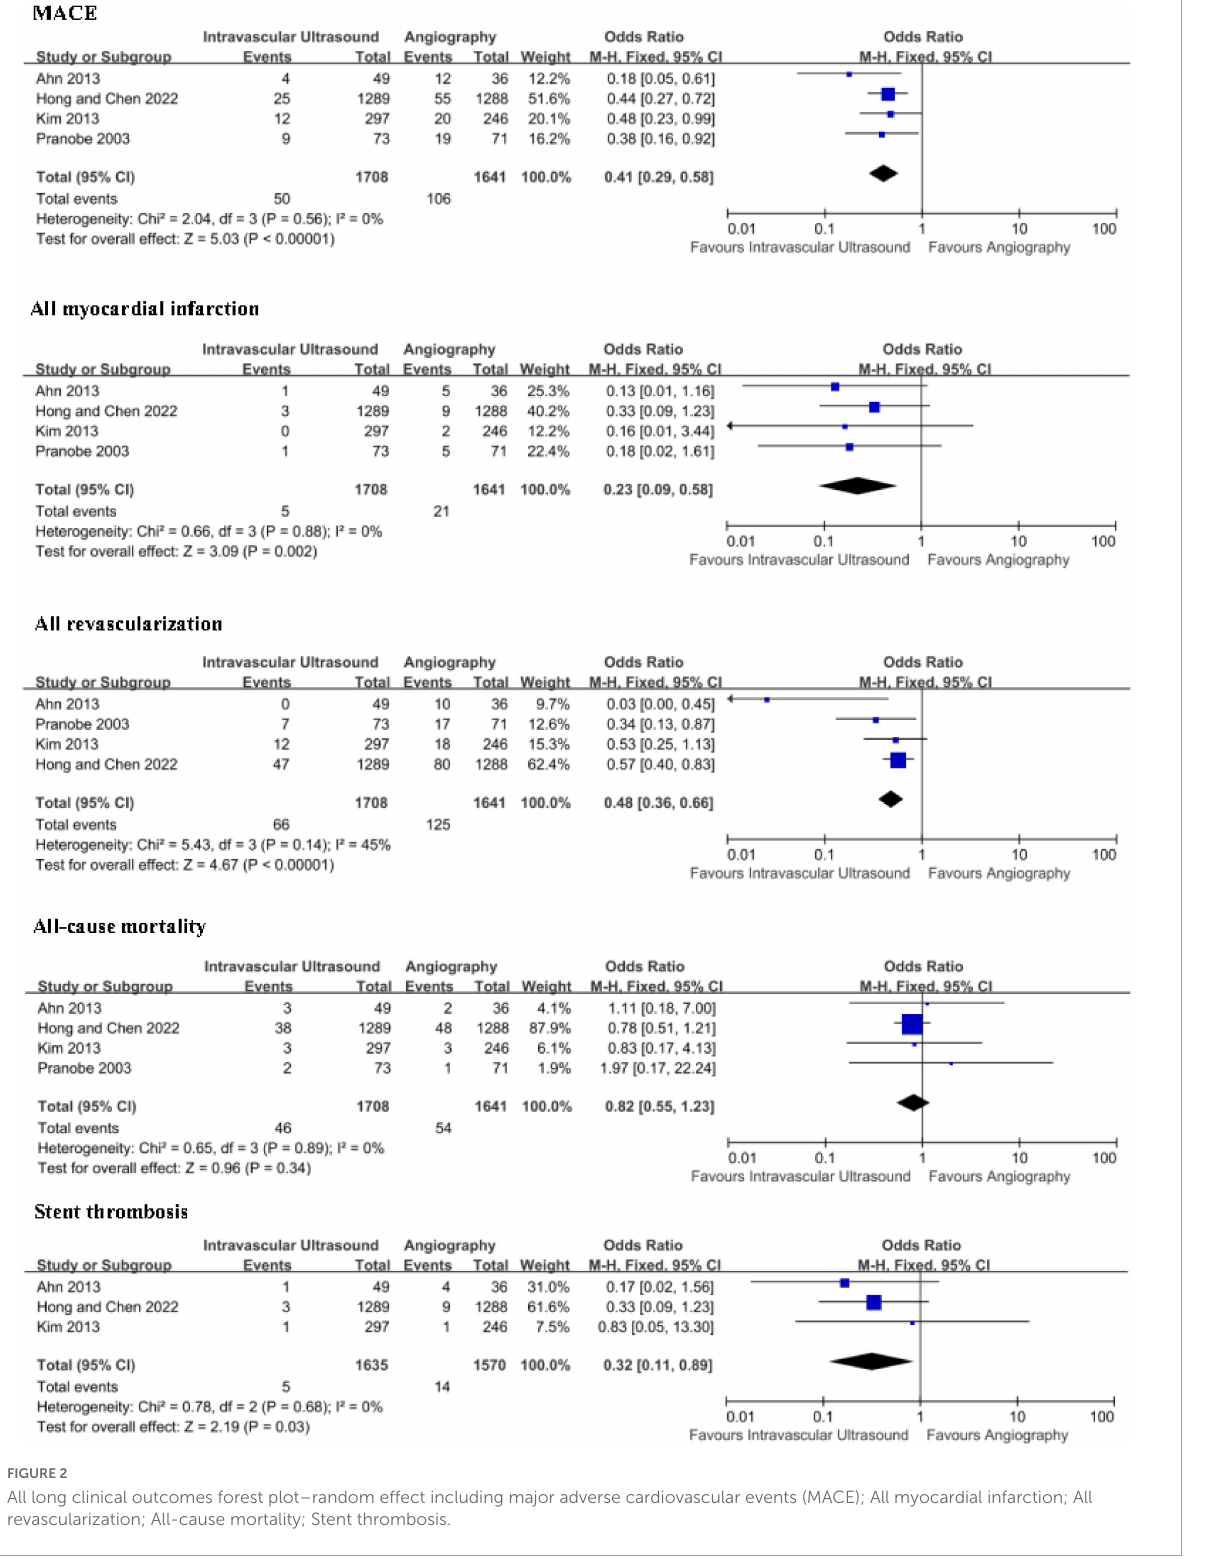
Frontiers in Cardiovascular